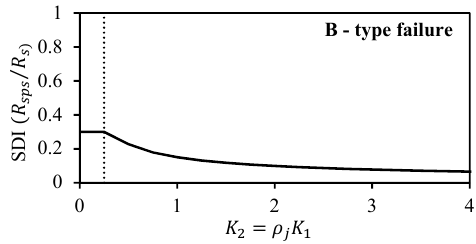
Figure 19. SD index corresponding to BJ-Failure.